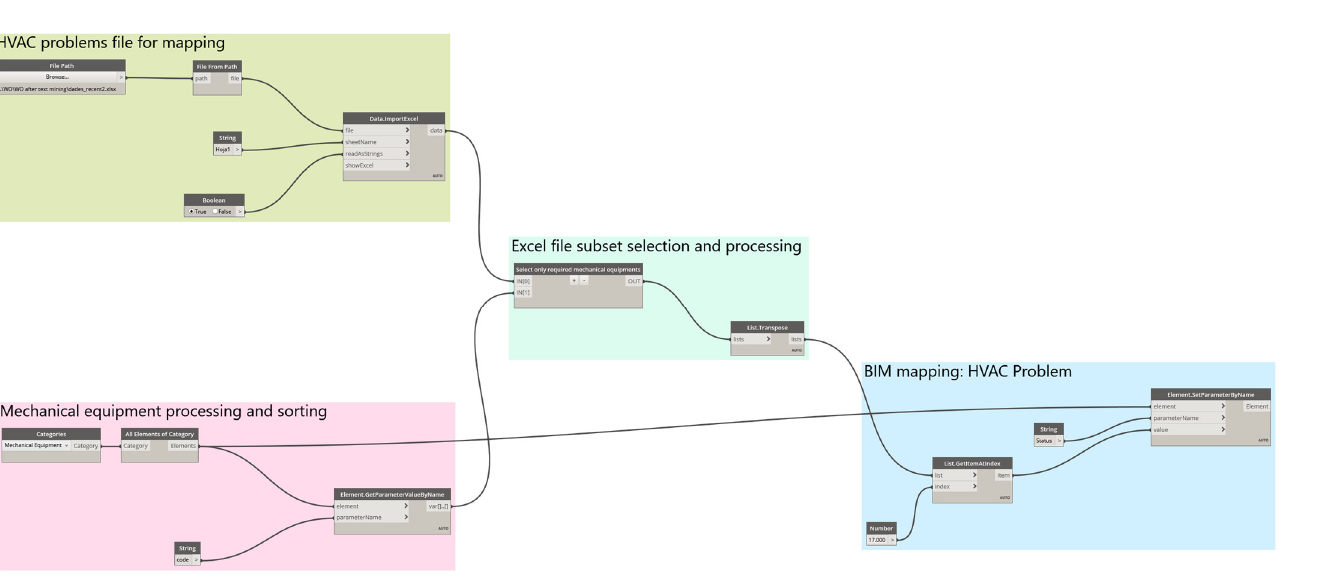
Figure 3. Dynamo scripts to map HVAC problems into BIM.